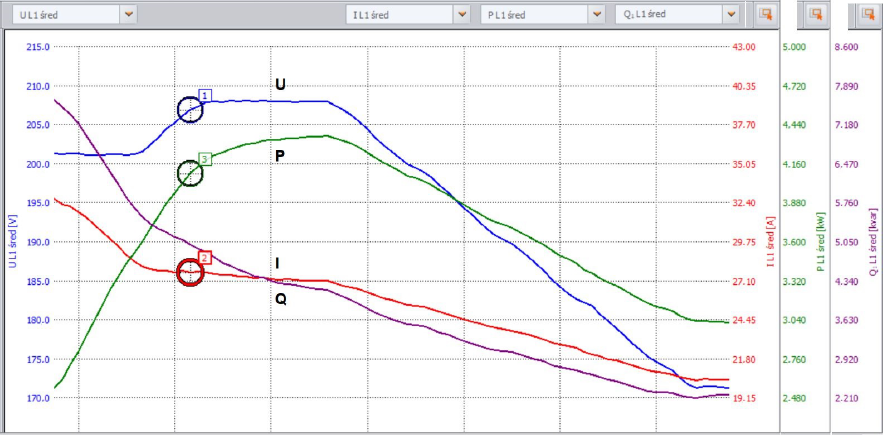
Figure 1. Characteristic of changes in the value of voltage, current, active power and reactive power in circuit 1 of the tested lighting installation—discharge sources.